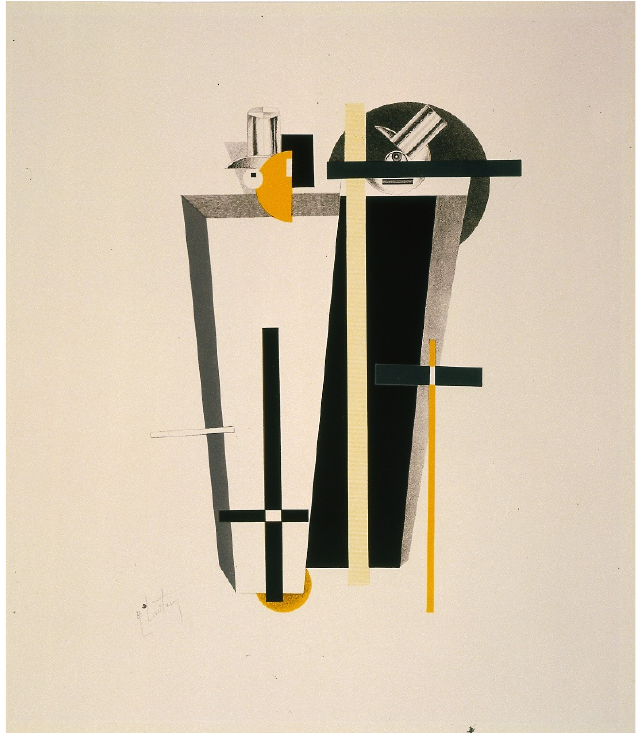
Figure 19. El Lissitzky, ‘The Gravediggers, lithograph for the ‘Figurinnenmappe’, 1923. Van Abbe ‐ museum. Photo: Peter Cox.